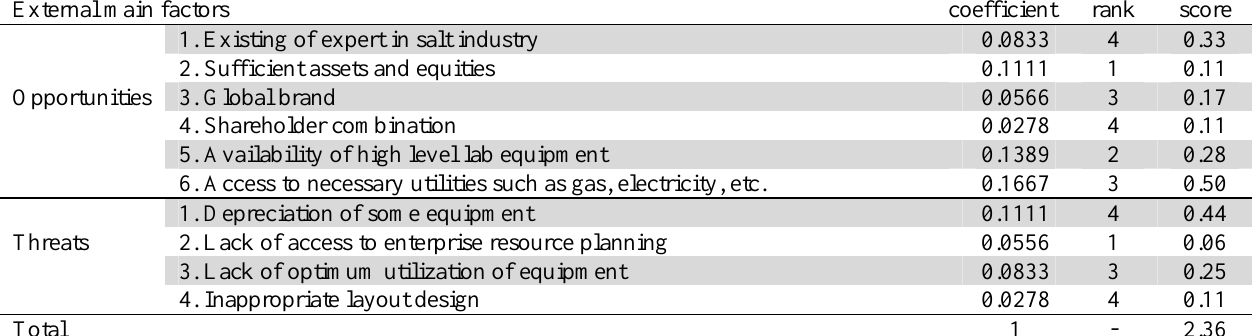
Internal factor evaluation (IFE) for criteria associated with the proposed study External main factors